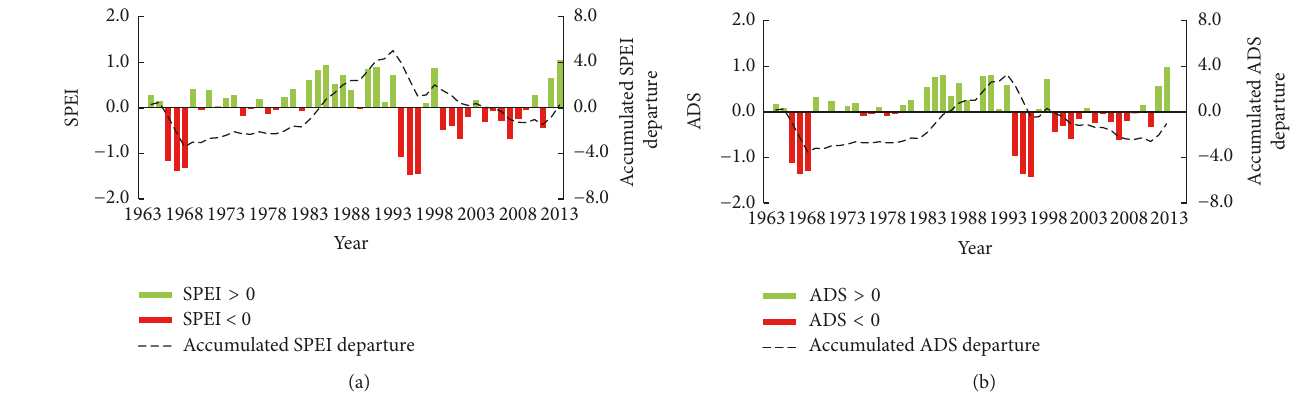
Figure 2: The interannual variability of (a) annual SPEI value and (b) annual ADS